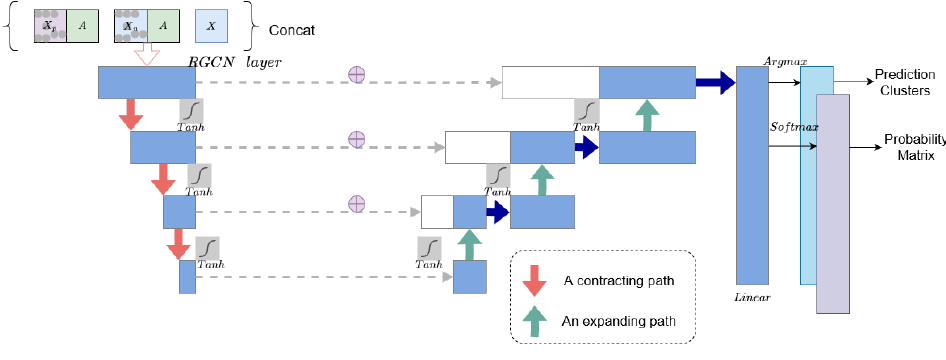
Figure 1. Framework of